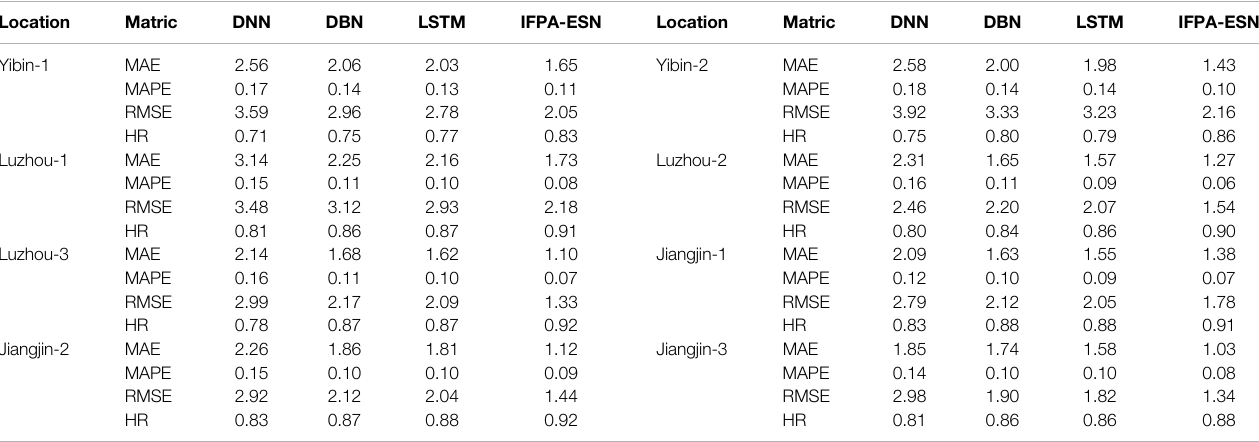
TABLE 7 | Nitrate concentration prediction with chaotic modeling approach.